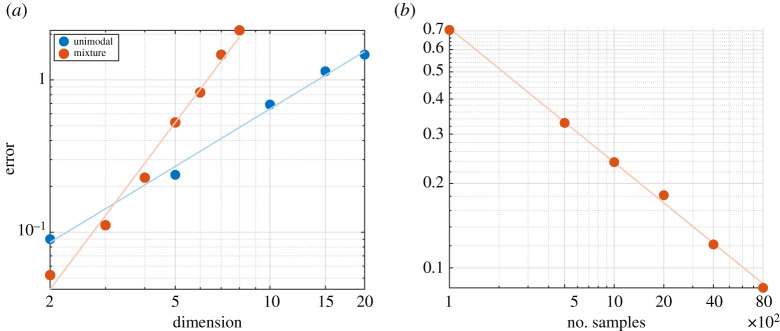
Numerical error estimates for multivariate Gaussian sampling. (a) Logarithmic plot of average error for a multivariate Gaussian distribution (blue) and a mixture of two Gaussians (red) as a function of dimension; linear fits are shown with solid lines. (b) Logarithmic plot of average error for a five-dimensional Gaussian distribution with respect to number of samples.